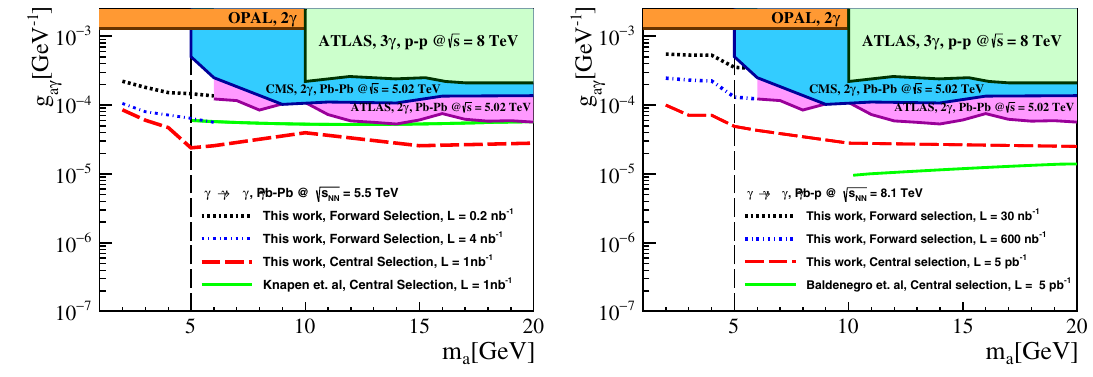
√ = 5 . 5 TeV and Pb – p collisions at s at nn are represented by dashed lines in the left and right